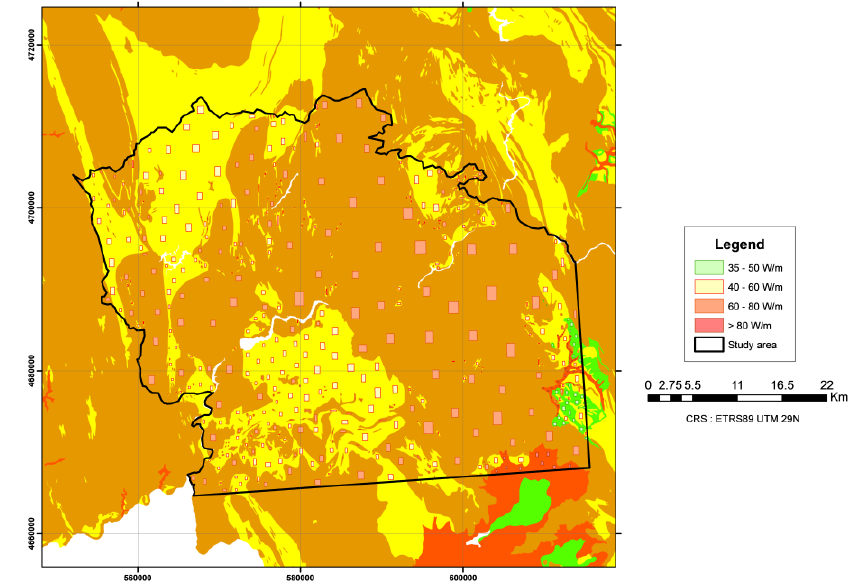
Figure 3. Distribution the training areas on the Web Map Service of the International Renewable Energy Agency (IRENA) [49].